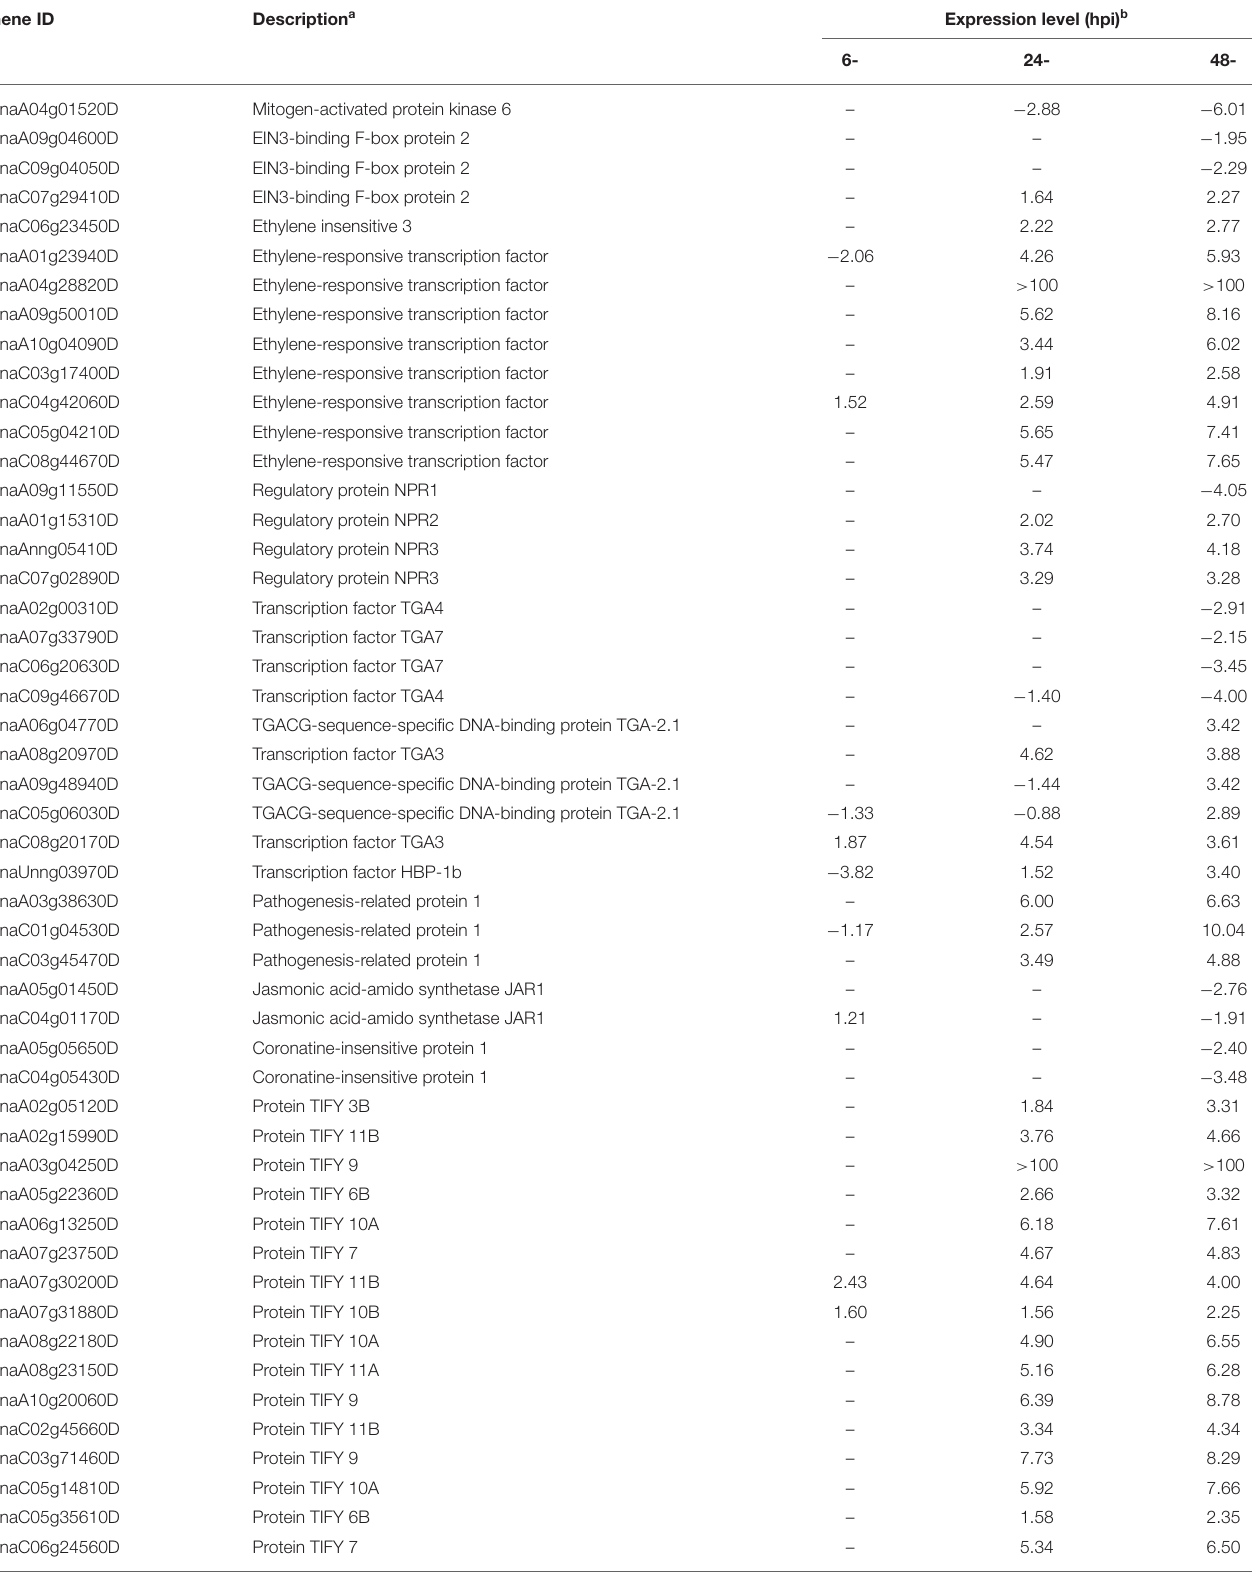
TABLE 1 | Description and expression of genes in B. napus involved in the hormone signaling pathway. Gene